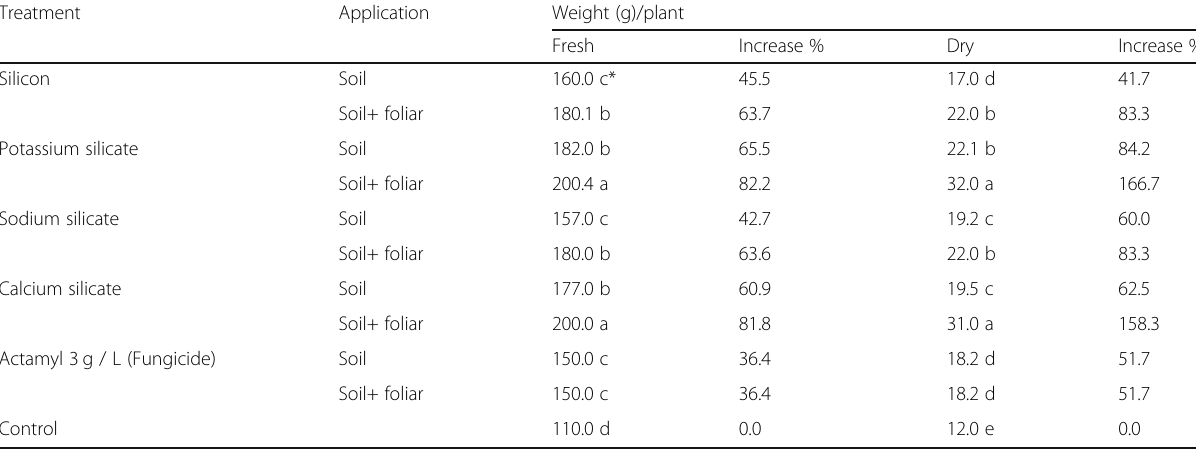
Table 3 Effect of silicon as well as potassium, sodium and calcium silicates on weight of strawberry plants under field conditions